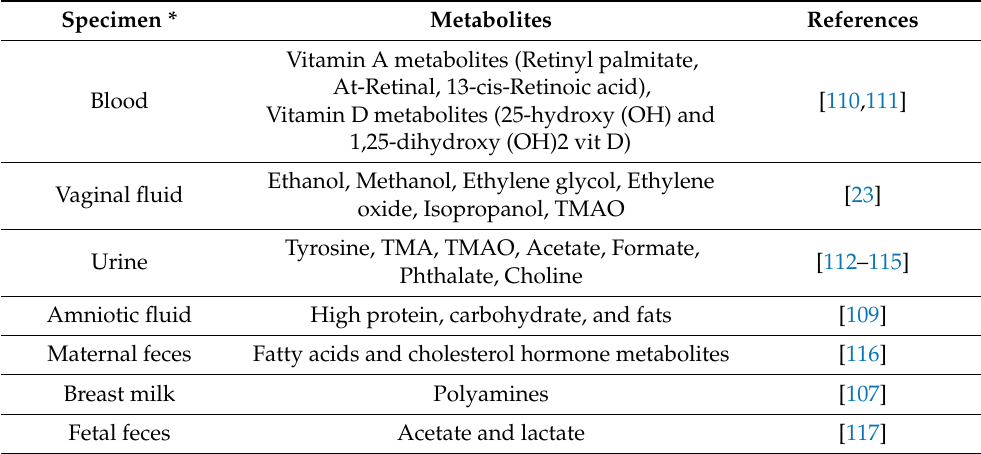
Table 3. Microbiota metabolites generated in preterm